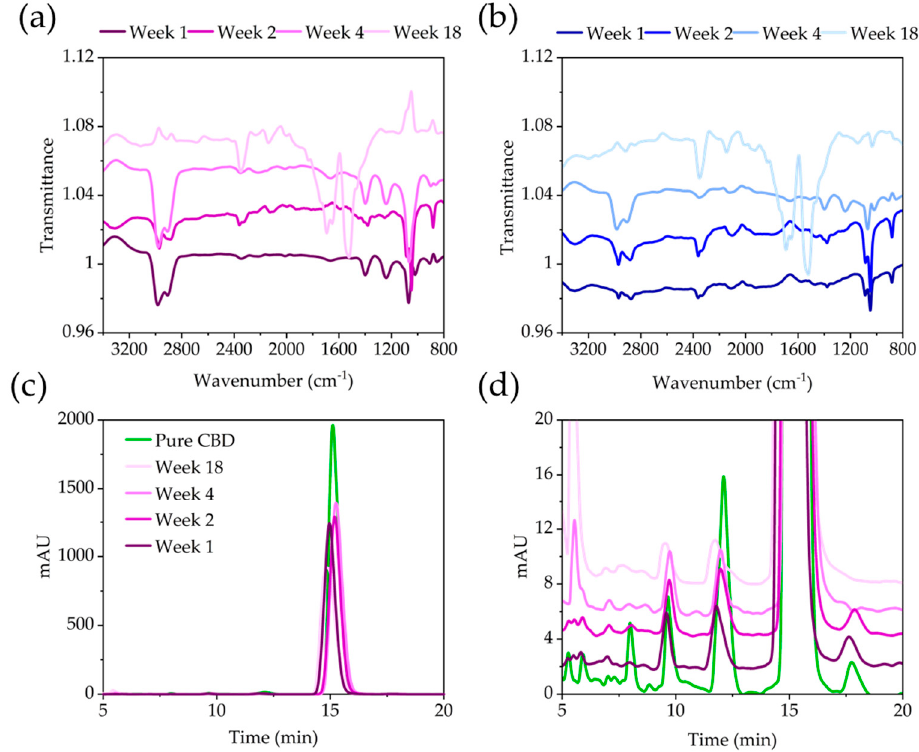
Figure 5. Stability of CBD extracted from PVA-CBD-Silica particles after prolonged storage. FT-IR spectra of samples stored at ( a ) 40 °C and 60% humidity and ( b ) 4 °C for up to 18 weeks. ( c ) Chro- matogram of samples stored at 40 °C and 60% humidity compared to that of pure CBD, and ( d ) an inset showing the lower intensity peaks. Samples have been stacked for ease of viewing.